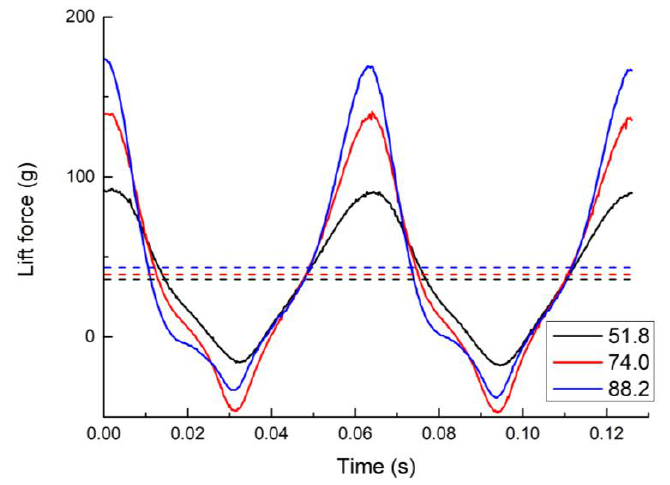
Figure 23. The flapping frequency-lift force line chart of three different flapping amplitudes with the same passive torsion